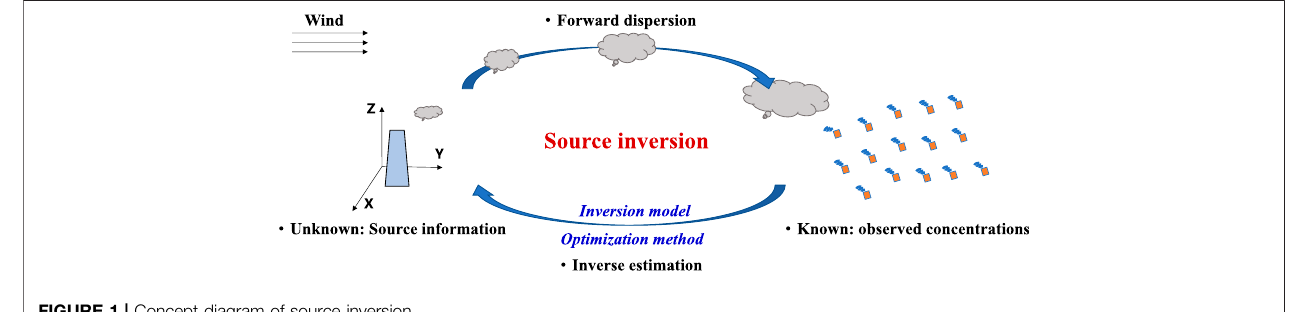
FIGURE 1 | Concept diagram of source inversion.